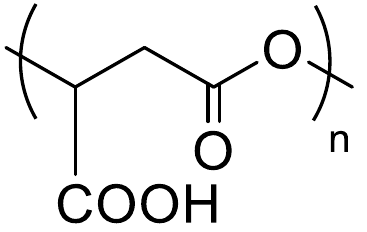
Figure 2. Structure of poly(malic acid) (PMLA).